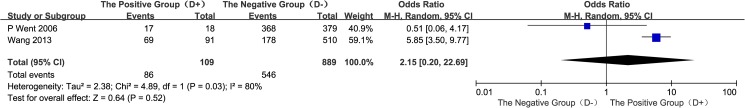
Meta-analysis of overexpression of EpCAM in D (+) and D (–) gastric cancer group.